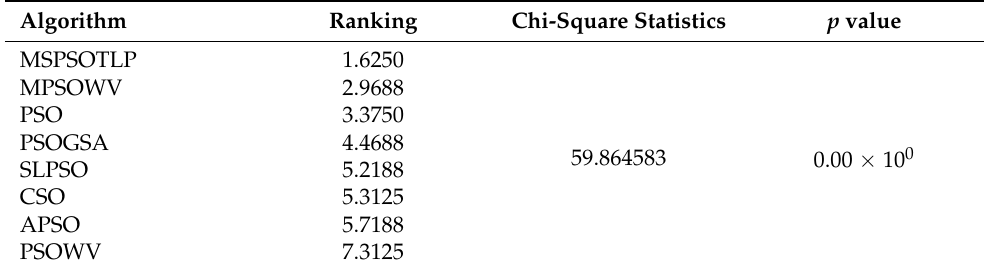
Table 16. The average ranking values of ANN models are trained by all compared algorithms in solving testing